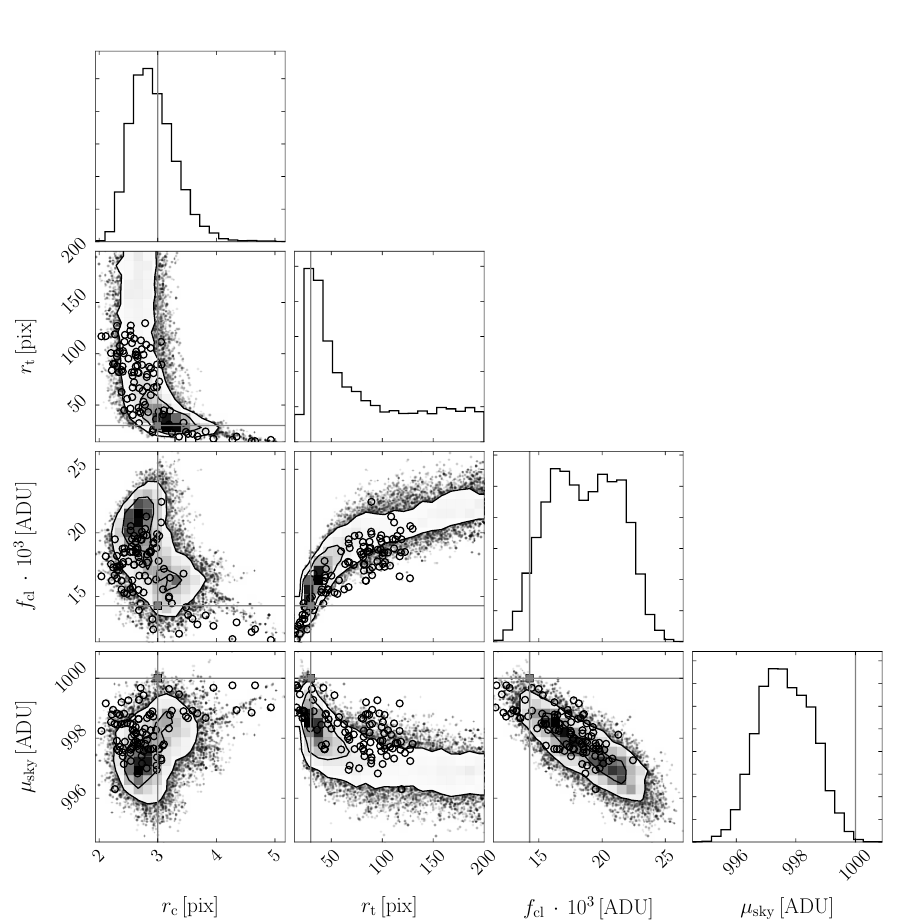
Fig. 2. Posterior distributions of core, r c , and tidal, r t , radii, flux f cl , and sky back- ground µ sky , shown as histograms and two parameter covariance plots for a star cluster with S/N = 20 and µ sky = 10 3 ADU. Contours are shown at 1- and 2- σ levels. True parameter values are indicated by an intersection of large cross-bars. Open circles show median values of the recovered parameter distributions of 100 simulated clusters with the same input parameters but different randomization of Poisson noise. by the number of pixels that are unaffected by the cluster’s flux ( r > r t